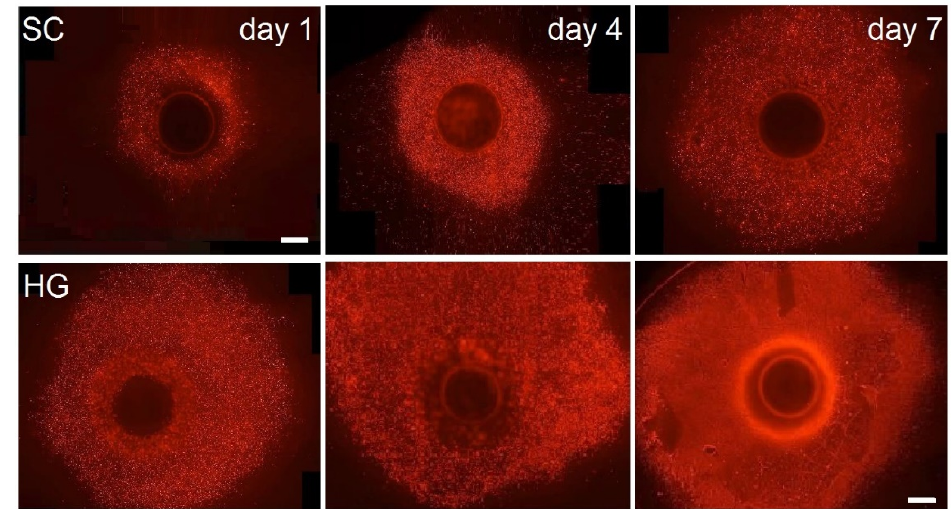
Figure 5. Images from fluorescence microscopy of bone osteoblasts on scaffolds on the 1st, 4th and 7th test days—propidium iodide staining. The images consist of shots taken by microscope auto-focus in z-axis, 1 µ m step; the scale is 1 mm. SC—scaffold with conventionally seeded cells, HG—scaffolds with printed hydrogel.